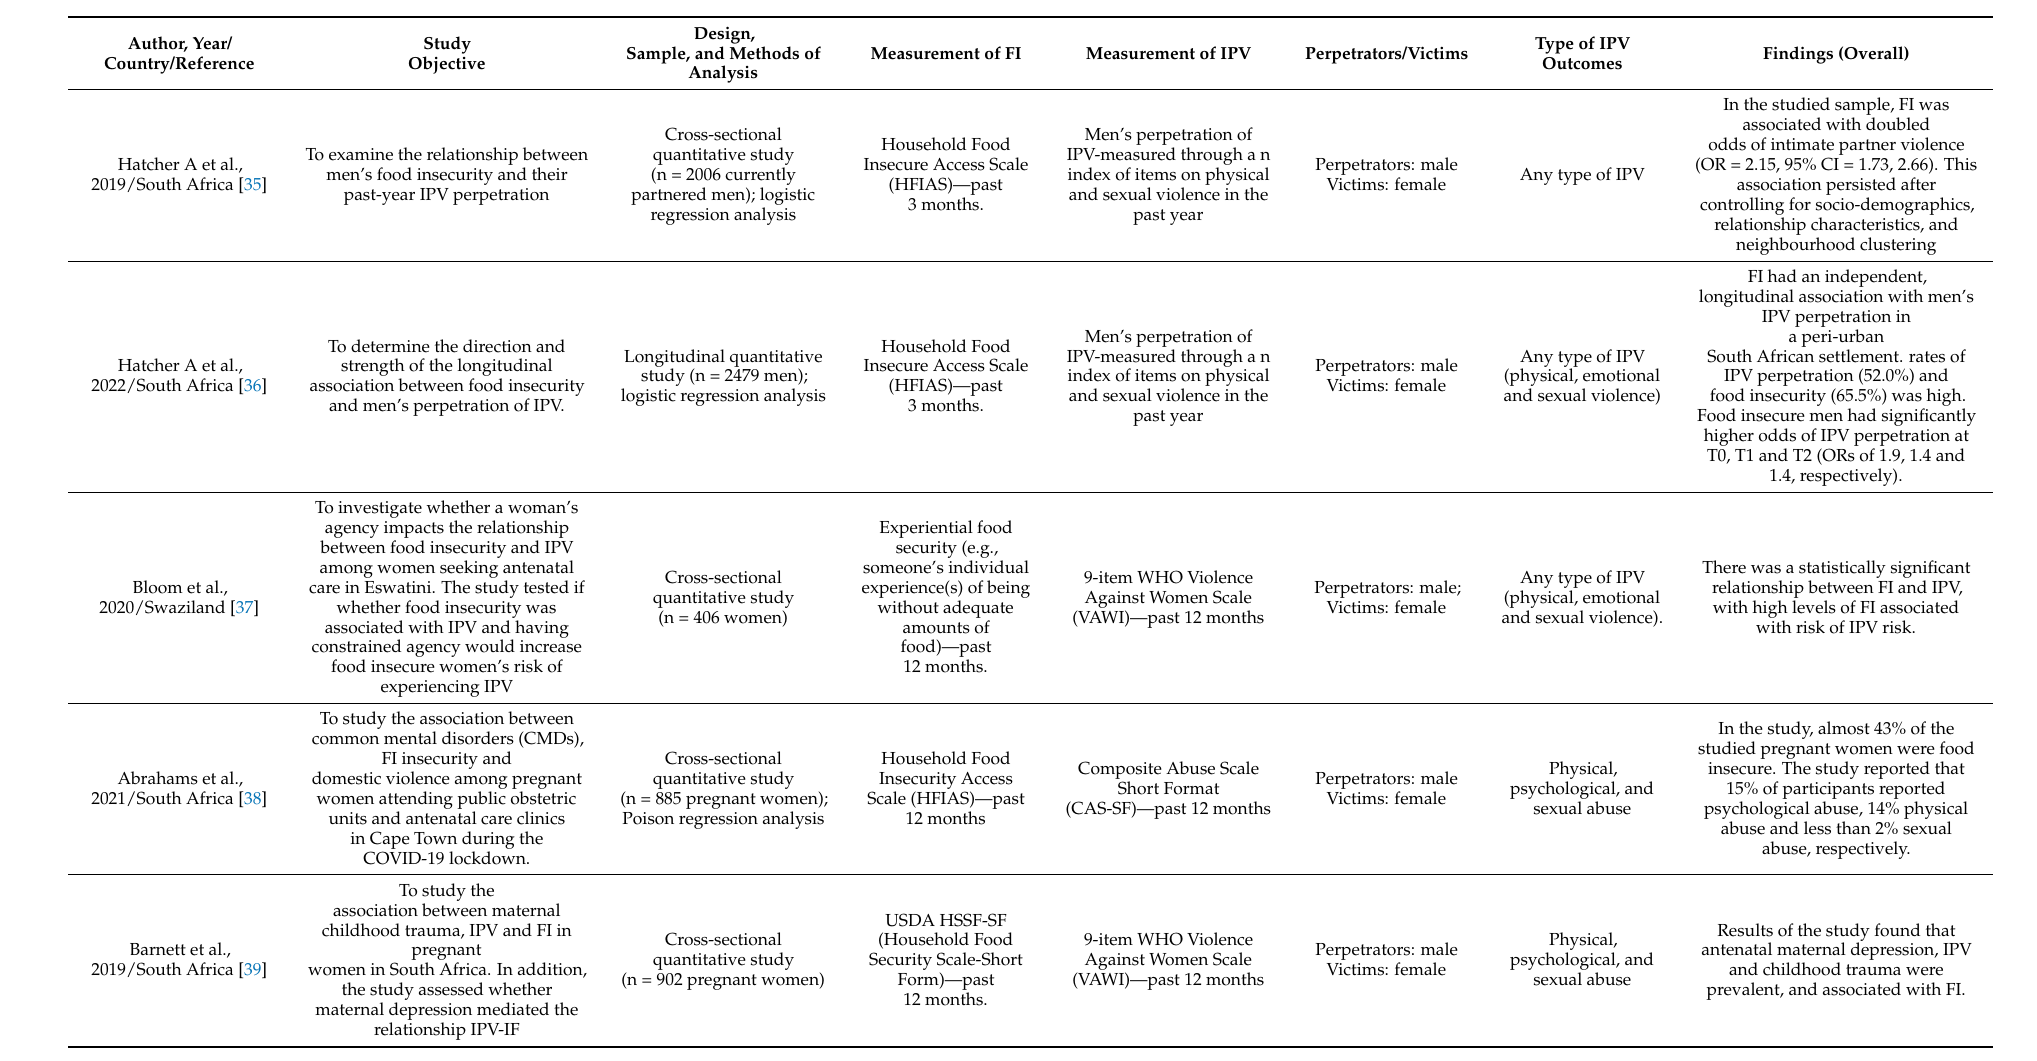
Table 1. Summary of 5 studies included in the systematic review (Authors own processing of the results of the identified